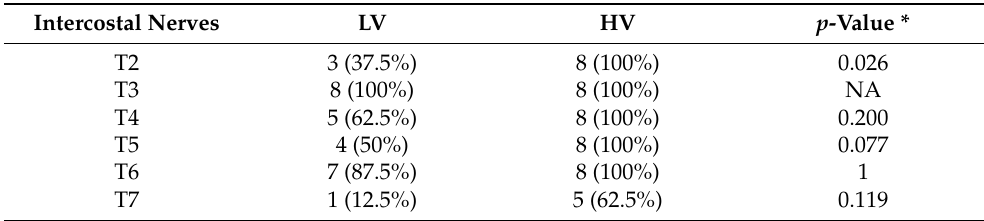
Figure 5. The figure shows the intercostal nerves stained between T2–T7 (black points) and the spread of the injectate along the intercostal TTP segments (grey columns) after the injection of a low volume (0.5 mL kg − 1 ) and a high volume (1 mL kg − 1 ) of the methylene blue and lidocaine solution in eight canine cadavers (a total of sixteen two-point injections). The numbers from 1 to 8 represent the different individuals in the study. HV, high volume; LV, low volume. Table 1. The table shows the number and percentage of intercostal nerves between T2–T7 stained after performing the two-point technique for the transverse approach to the transversus thoracis plane with both volumes.